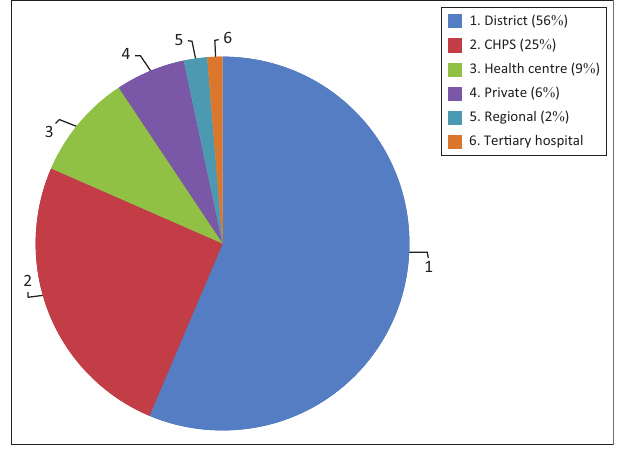
FIGURE 3: Health facilities visited for treatment of eye disease.